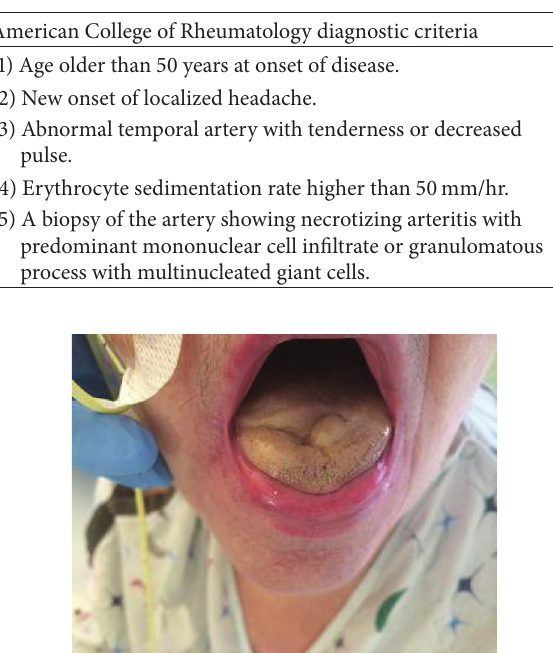
Table 1: Three out of five criteria are required to make the diagnosis of GCA.